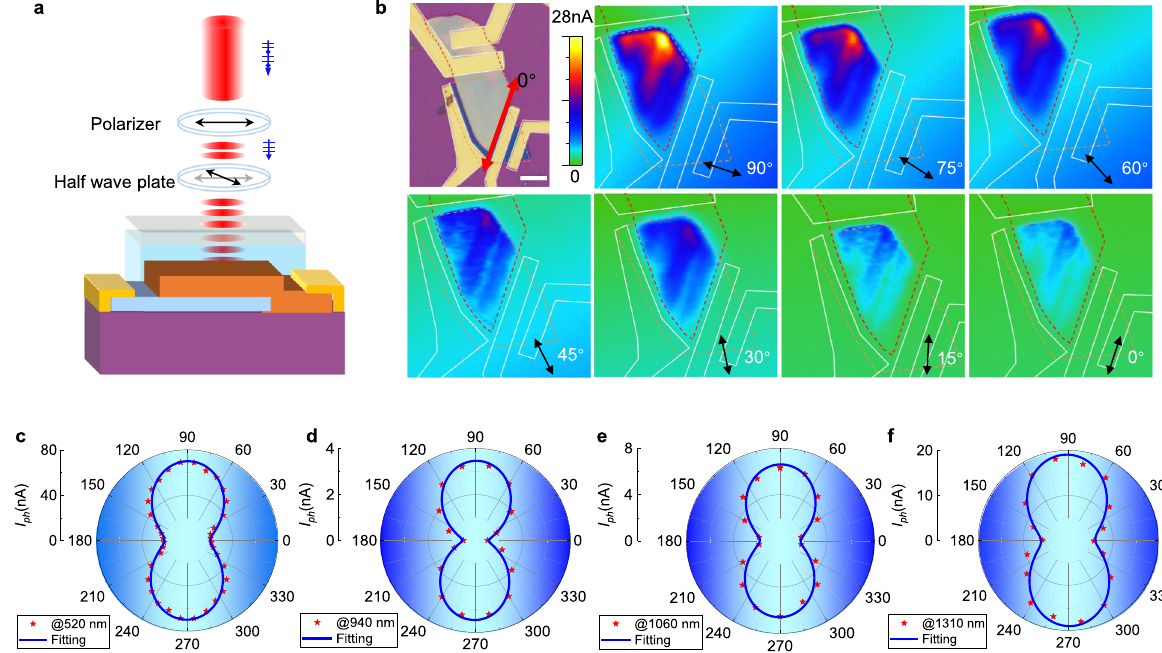
Fig. 5 Polarization detection characteristics of the GeSe/MoS 2 Fe-VHJ. a Schematic of the test setup. b Photocurrent mapping of the GeSe/MoS 2 Fe- VHJ. c – f Photocurrent as a function of the incident light polarization angle. The wavelength ranges from visible to near-infrared wavelengths (520, 940, 1060, and 1310 nm). The solid line represents fi tting using a sinusoidal function I ph ( δ ) = I py cos 2 ( δ + φ ) + I px sin 2 ( δ + φ ). The fi tted dichroic ratios under different wavelengths are 5.53, 6.25, 3.80, and